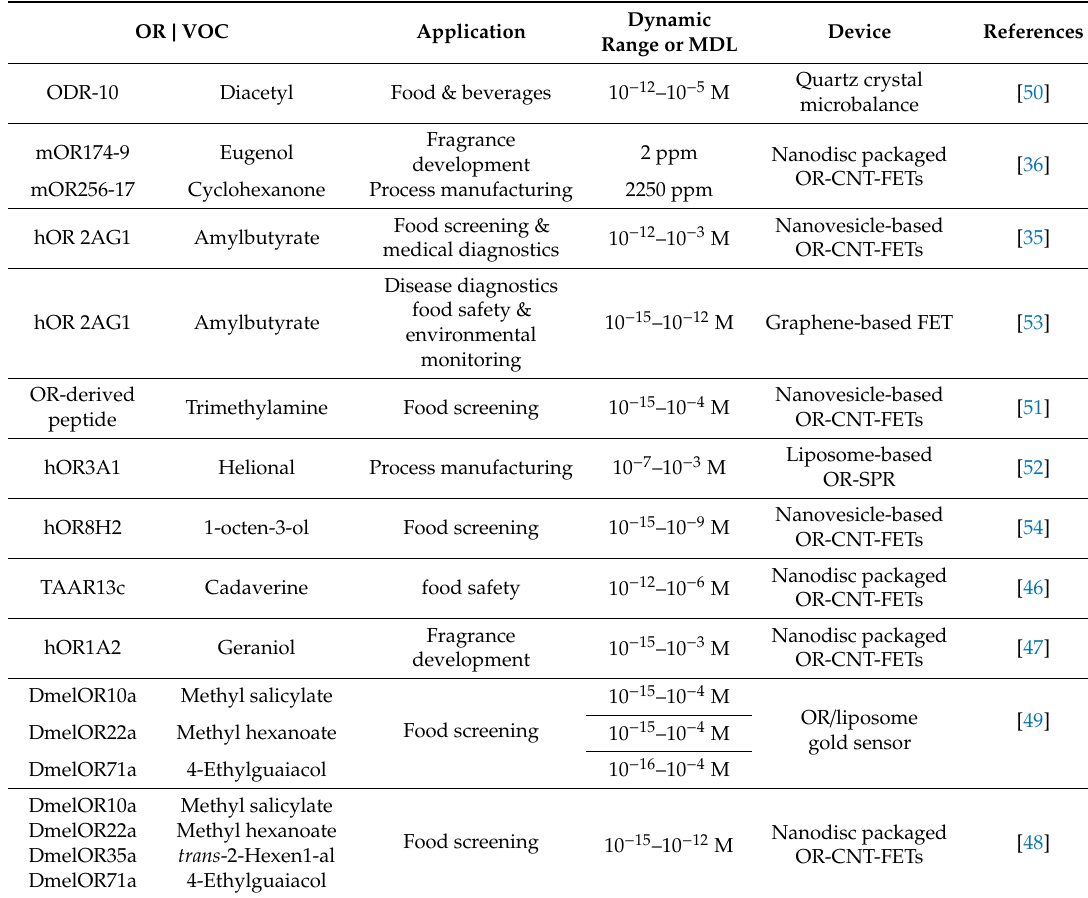
Table1. SummaryofOR-basedbiosensors. hOR,humanodorantreceptor;DmelOR, Drosophilamelanogaster odorant receptor; MDL, minimum detection limit. Data cited from: Jin et al. [35]; Goldsmith et al. [36]; Yang et al. [46]; Lee et al. [47]; Murugathas et al. [48]; Khadka et al. [49]; Sung et al. [50]; Lim et al. [51]; Oh et al. [52]; Park et al. [53]; and Ahn et al.